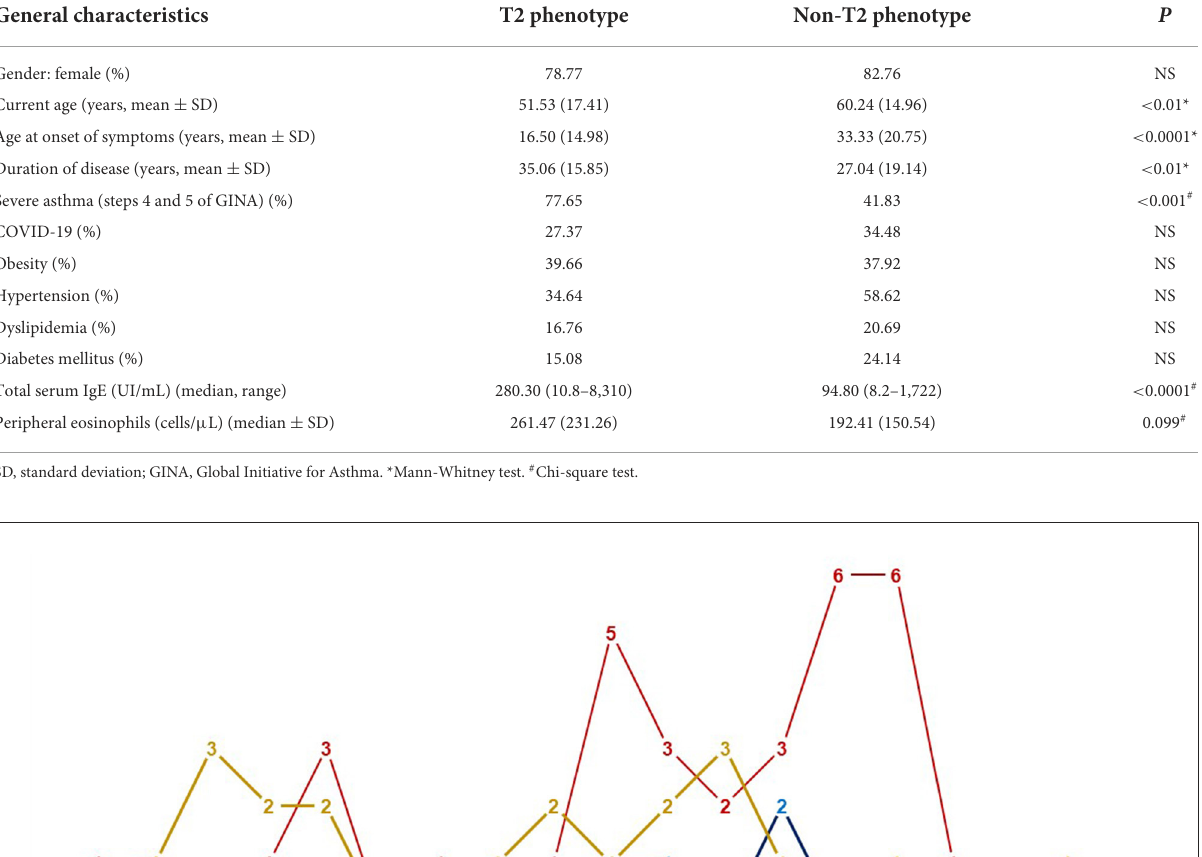
TABLE 3 Asthmatic patients according to inflammatory phenotypes (T2/ non-T2).